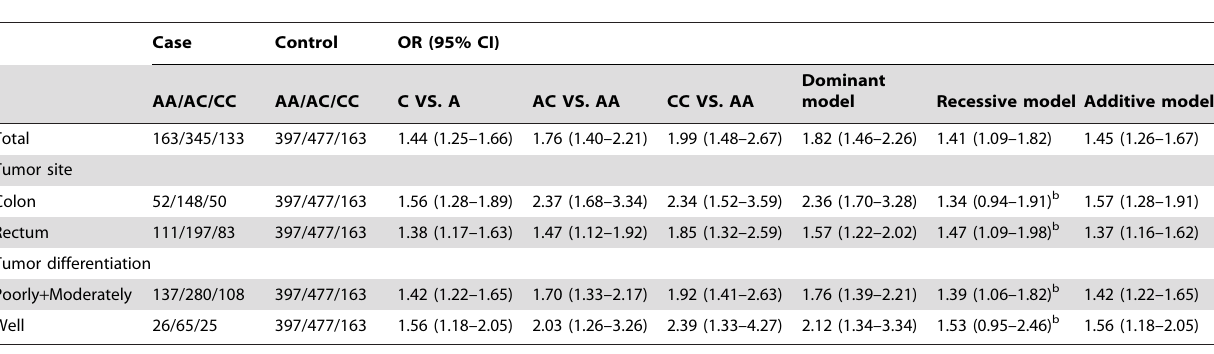
Table 2. Association between rs3802842 and colorectal cancer risk in a Chinese population a